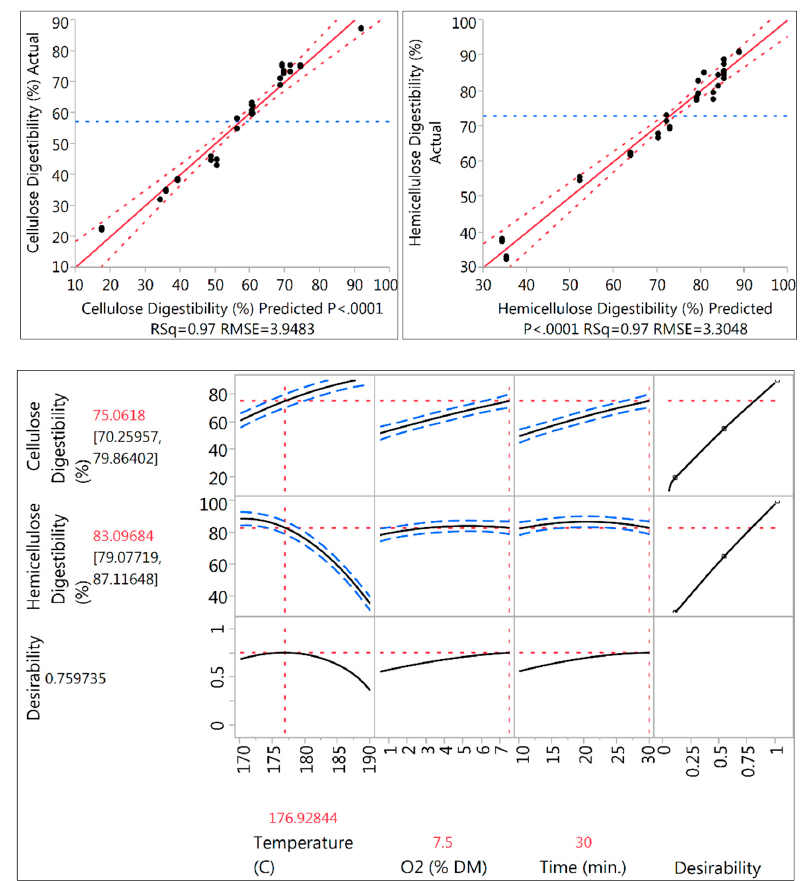
Figure 3. Fitted correlation of actual and predicted values, showing cellulose digestibility and hemicellulose digestibility with p -values and the coefficient of determination (R 2 ). The maximum desirability in the predictive model is showing the cellulose digestibility and hemicellulose digestibility under different pretreatment conditions and with an optimal set of conditions.